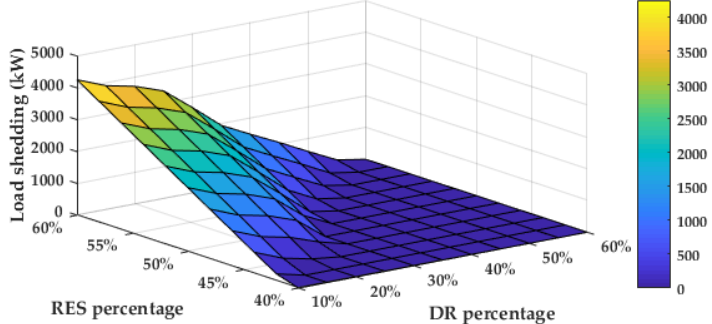
Figure 11. Impact of DR percentage and RES percentage on load shedding. Appl. Sci. 2018 , 8 , x FOR PEER REVIEW